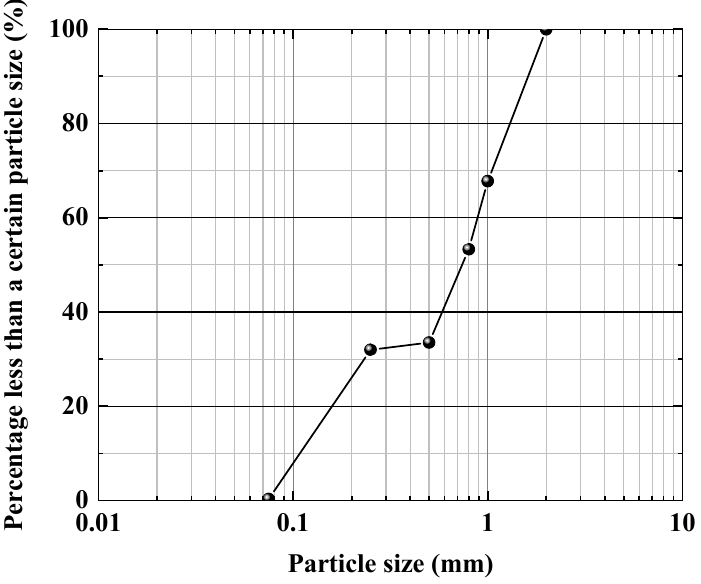
Figure 1. Particle gradation curve of the original sand specimen.